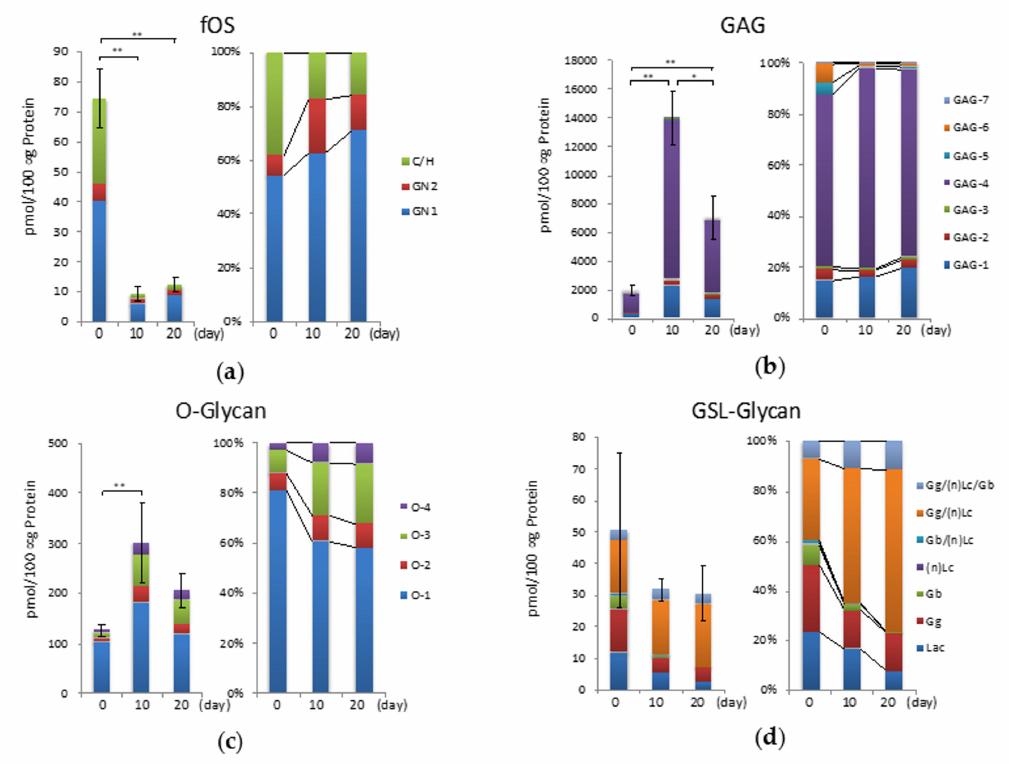
Figure 6. Total cellular glycomes of fOS, GAG, and O- and GSL-glycan during hypertrophic di ff erentiation. ( a ) The absolute and relative amounts of fOS types. (GN1, fOS with a single GlcNAc residue; GN2, N,N-diacetylchitobiose moiety of fOS; C / H, Complex / hybrid-type fOS.) ( b ) The absolute and relative amounts of disaccharidic GAGs. Analysis of GAGs was performed with HPLC. ( c ) The absolute and relative amounts of O-glycans. ( d ) The absolute and relative amount of the GSL-glycan series. (Lac, Laccer; Gg, Ganglioside series; Gb, Globo series; (n)Lc, (neo)Lacto series). The results are expressed as the means ± S.D. * 0.01 < p < 0.05; ** p < 0.01. All MALDI-TOF-MS and HPLC measurements were independently carried out ( n = 3). The prepared glycan structures are listed